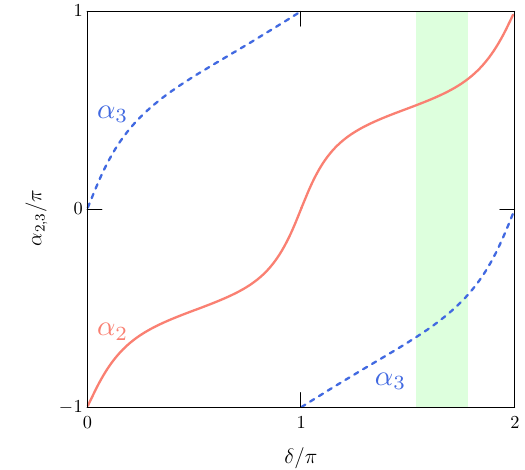
Fig. 7 Majorana phases α i as functions of δ . We fix the other neutrino oscillation parameters to be their best-fit values. The green band depicts the 2 σ favored region of δ predicted in the minimal gauged U ( 1 ) L μ − L τ model α ( − δ) = − α (δ) (or α (π − δ) = − α (π + δ) ), 2 , 3 2 , 3 2 , 3 2 , 3 as discussed in Sect.